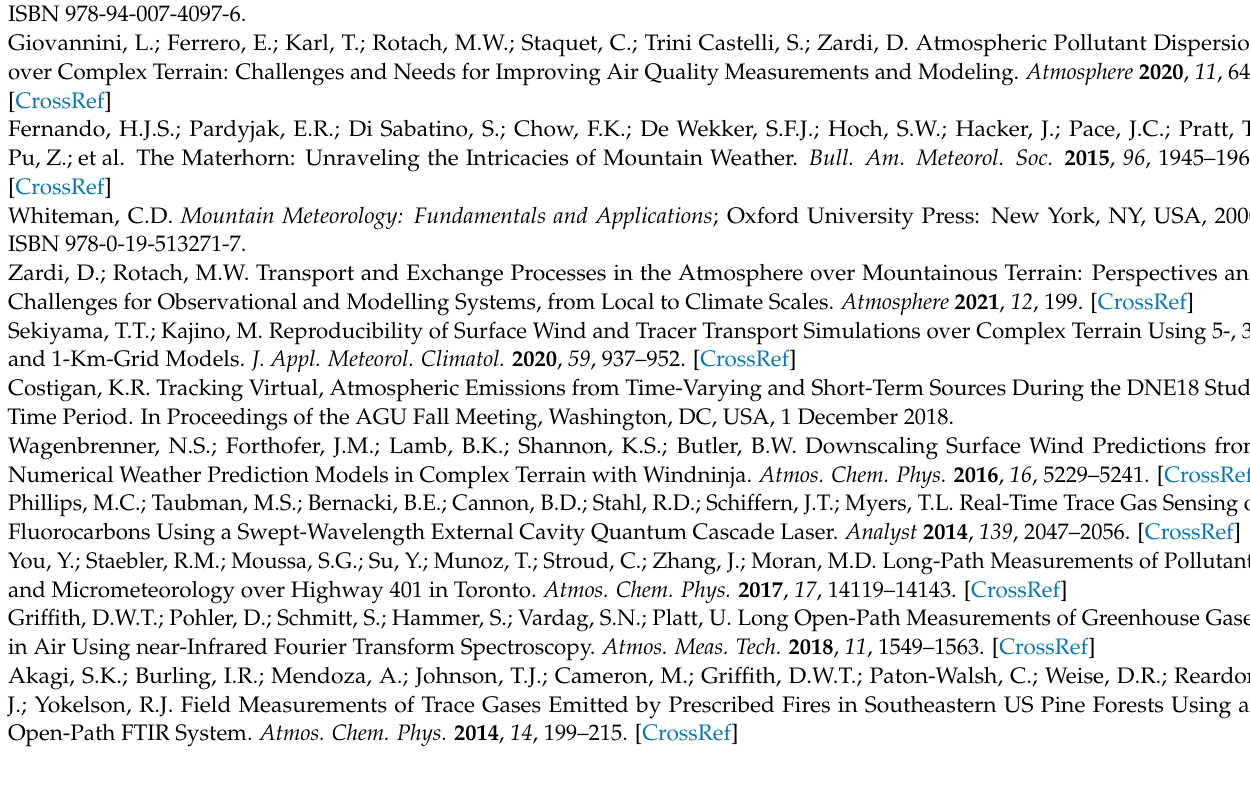
allowing reduction of noise via averaging.